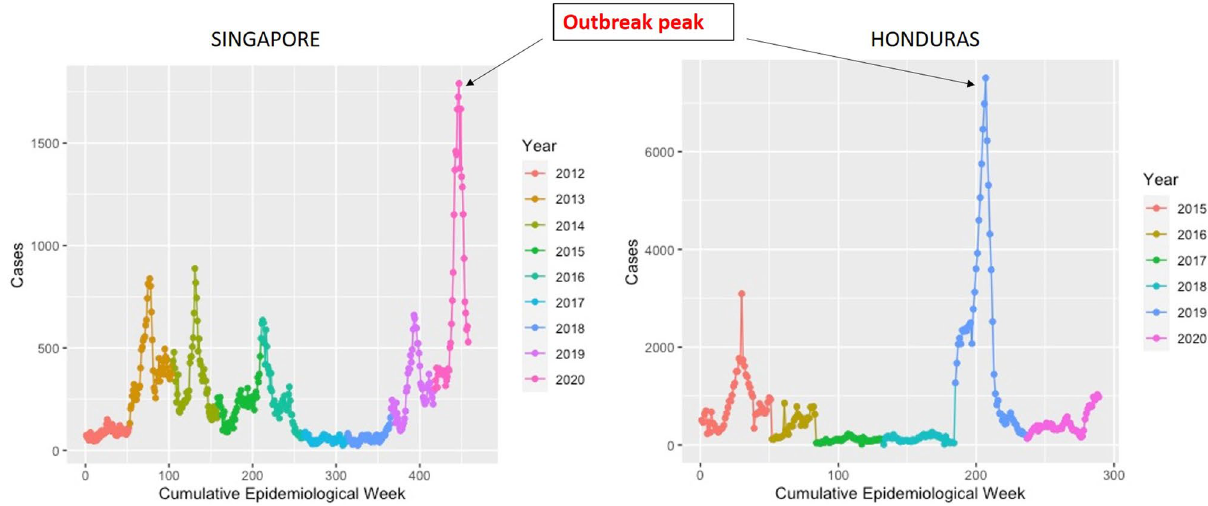
Figure 10. Graph showing the confirmed dengue cases (RT-PCR and DENV-IgM positive) in Singapore and Honduras from 2012 to 2020. Different years are represented with colors as shown in the figure. The peak outbreak period, 2019 for Honduras and 2020 for Singapore is denoted in the pink and blue, respectively.